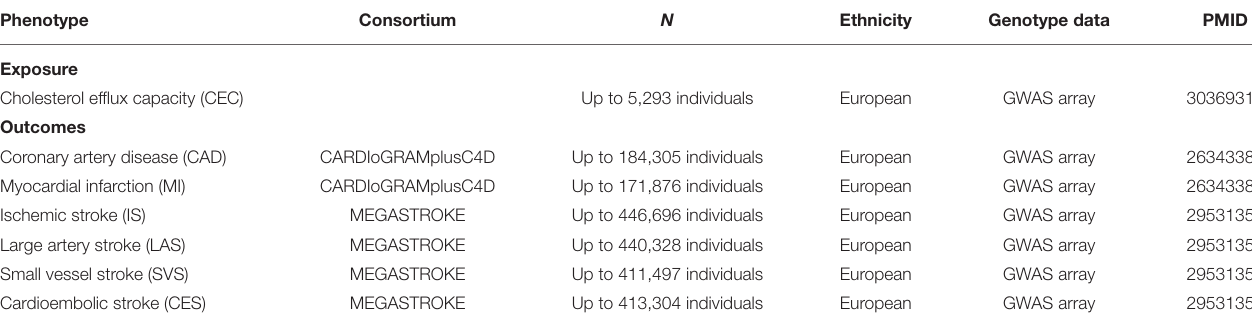
TABLE 1 | Characteristics of the GWAS studies used in this study.